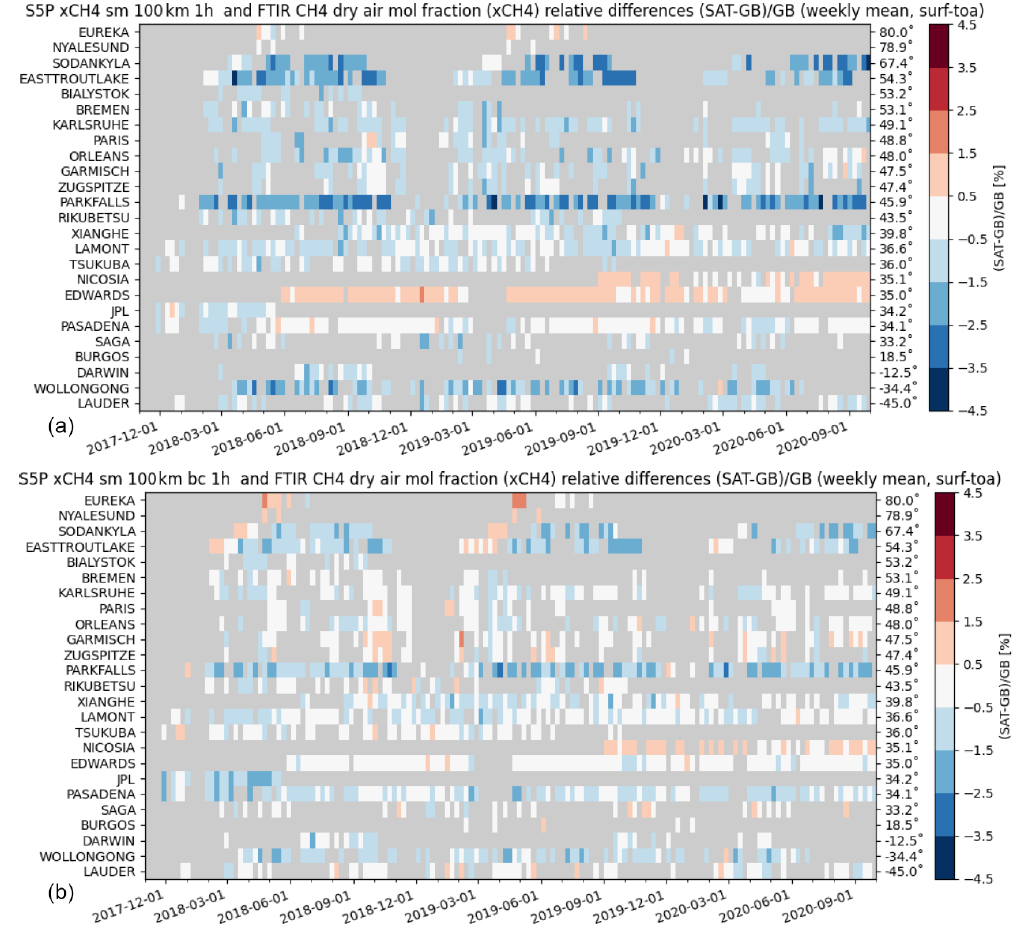
Figure 3. Mosaic plots showing relative biases between co-located S5P (standard XCH 4 product – a ; bias-corrected XCH 4 product – b ) and TCCON XCH 4 data with a priori alignment at 25 TCCON stations within the period between November 2017 and September 2020. Spatial co-location with radius of 100km and time of ± 1h around the satellite overpass was used. The time resolution of the data shown here is weekly. The stations are sorted with decreasing